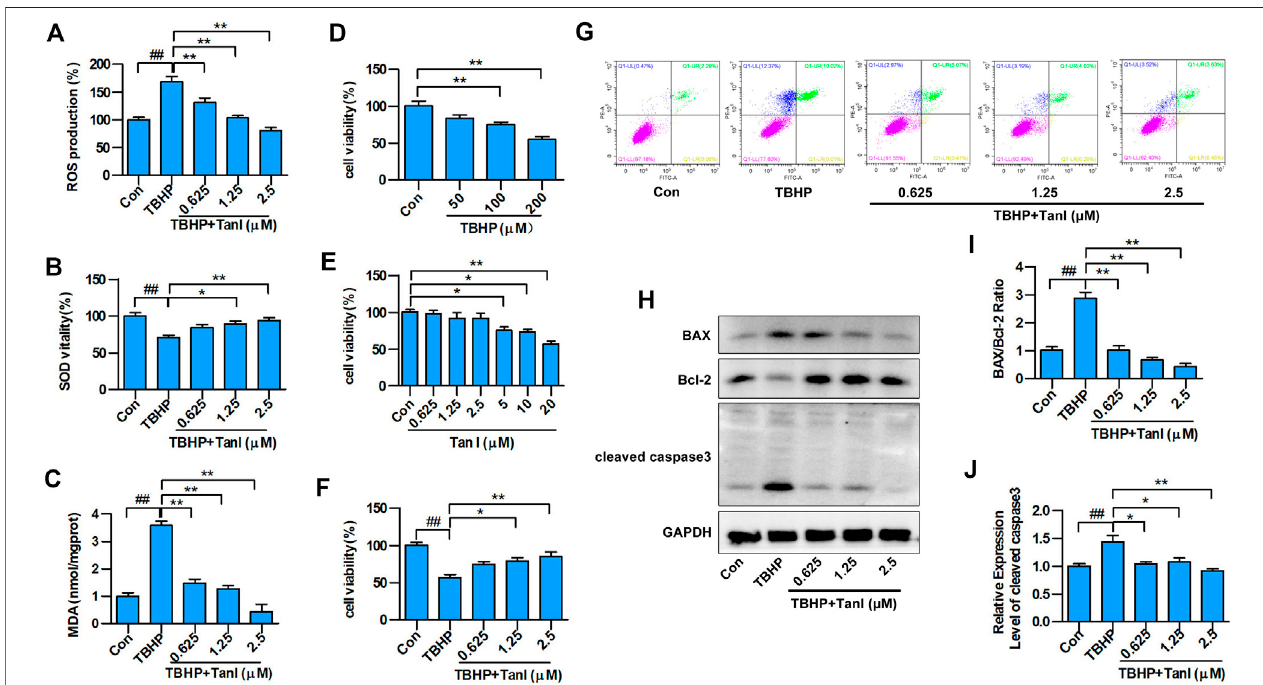
FIGURE 1 | Tan I inhibits oxidative stress and oxidative stress – induced H9C2 cell apoptosis. H9C2 cells were incubated with different concentrations of Tan I (0.625, 1.25, and 2.5 µM) and then treated with TBHP (200 µM). (A) Reactive oxygen species (ROS) levels ( n (cid:2) 3). (B) Superoxide dismutase (SOD) activity ( n (cid:2) 3). (C) Malondialdehyde (MDA) content ( n (cid:2) 3). (D) Viability of H9C2 cells incubated with different concentrations of TBHP ( n (cid:2) 3). (E) Viability of H9C2 cells incubated with different concentrations of Tan I ( n (cid:2) 3). (F) Viability of H9C2 cells incubated with different concentrations of Tan I (0.625, 1.25, and 2.5 µM), followed by treatment with TBHP (200 µM) ( n (cid:2) 3). (G) H9C2 cell apoptosis analysis ( n (cid:2) 3). (H) Expression levels of BAX, Bcl-2, and cleaved caspase3 measured using Western blot analysis ( n (cid:2) 3). (I) BAX/Bcl-2 ratio ( n (cid:2) 3). (J) Relative expression levels of cleaved caspase3 ( n (cid:2) 3). Data are presented as mean ± S.D. # p < 0.05, ## p < 0.01, compared to the